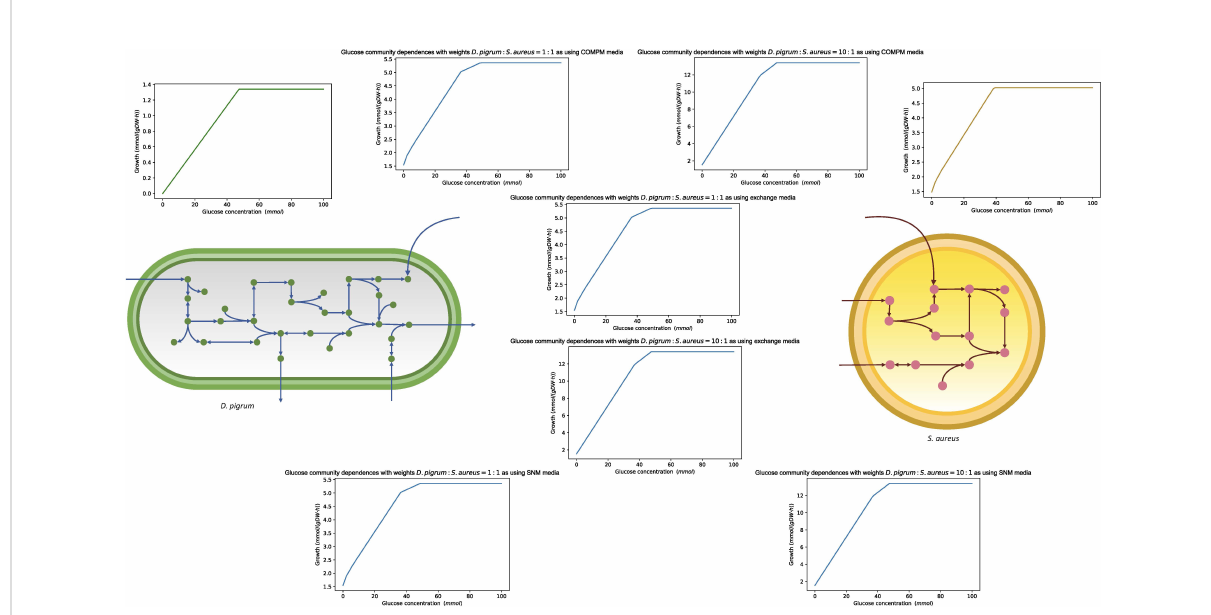
FIGURE 8 The fi gure with the green curve shows the linear dependency of glucose concentration in a single model of D. pigrum . In contrast, the one with gold color represents the slight dependency of the glucose concentration of S. aureus as it can grow even though the glucose concentration reaches zero. Each blue curve shows the glucose dependency in the community with all different media. We used a compartmentalized approach with shuttle reaction. Different weights were also